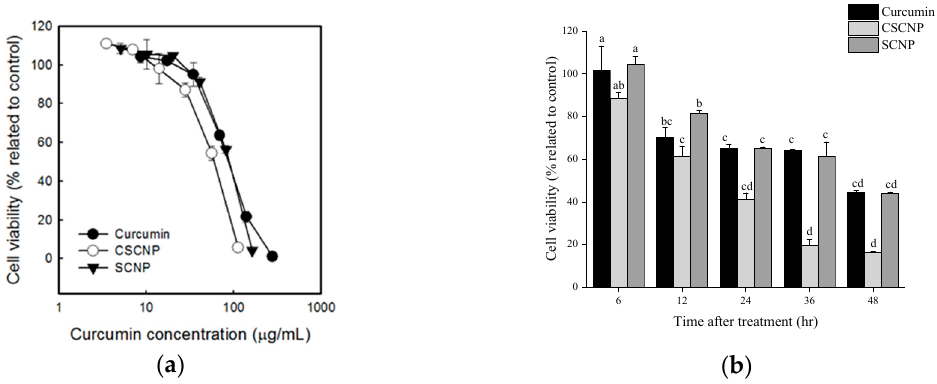
Figure 4. MTT assay of Hep G2 cells after different curcumin or nanoparticle dosages and time durations. The cells were treated with samples for ( a ) 48 h at different dosages and ( b ) 100 μ g/mL at different time intervals. The initial cell number was adjusted to 2 × 10 5 cells/mL. Data were shown by mean ± SD of 3 independent experiments ( n = 3) with 3 technical replicates. SCNP: silica-encapsulated curcumin nanoparticles; CSCNP: chitosan with silica co-encapsulated curcumin nanoparticles.